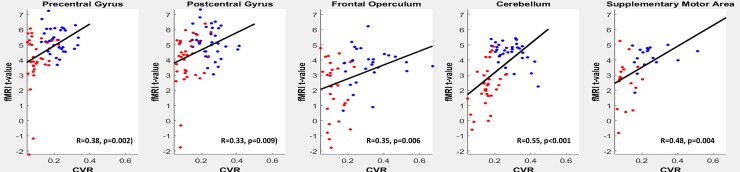
The fMRI t-values are represented as a function of the BOLD-CVR (relative BOLD fMRI signal change per mmHg CO2).Each red and blue point represents the average value of a ROI of a single subject during either normocpanie (blue) or hypercapnia (red). Black line: least square error linear fit of each scatterplot. Abbreviations: BOLD: blood oxygenation-level dependent; -CVR: cerebrovascular reactivity, CO2: carbon dioxide, %fMRI: mean percent BOLD signal changes, ROI: Region of Interest.